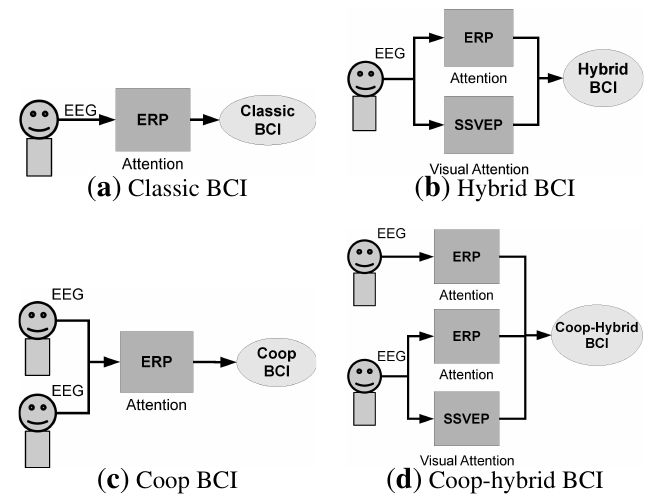
Figure 1. Examples of different BCI